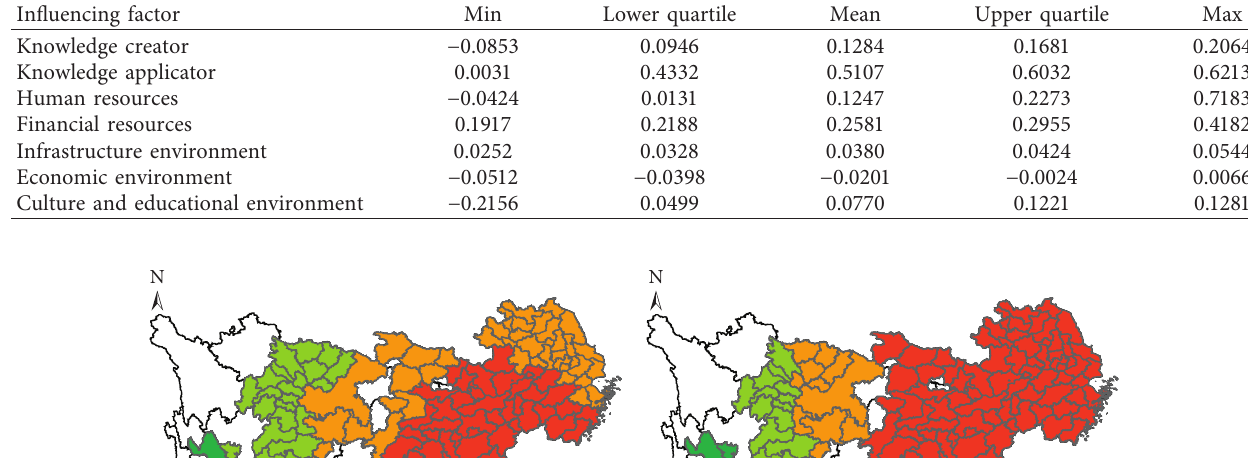
Table 3: Calculation results of the GWR model.